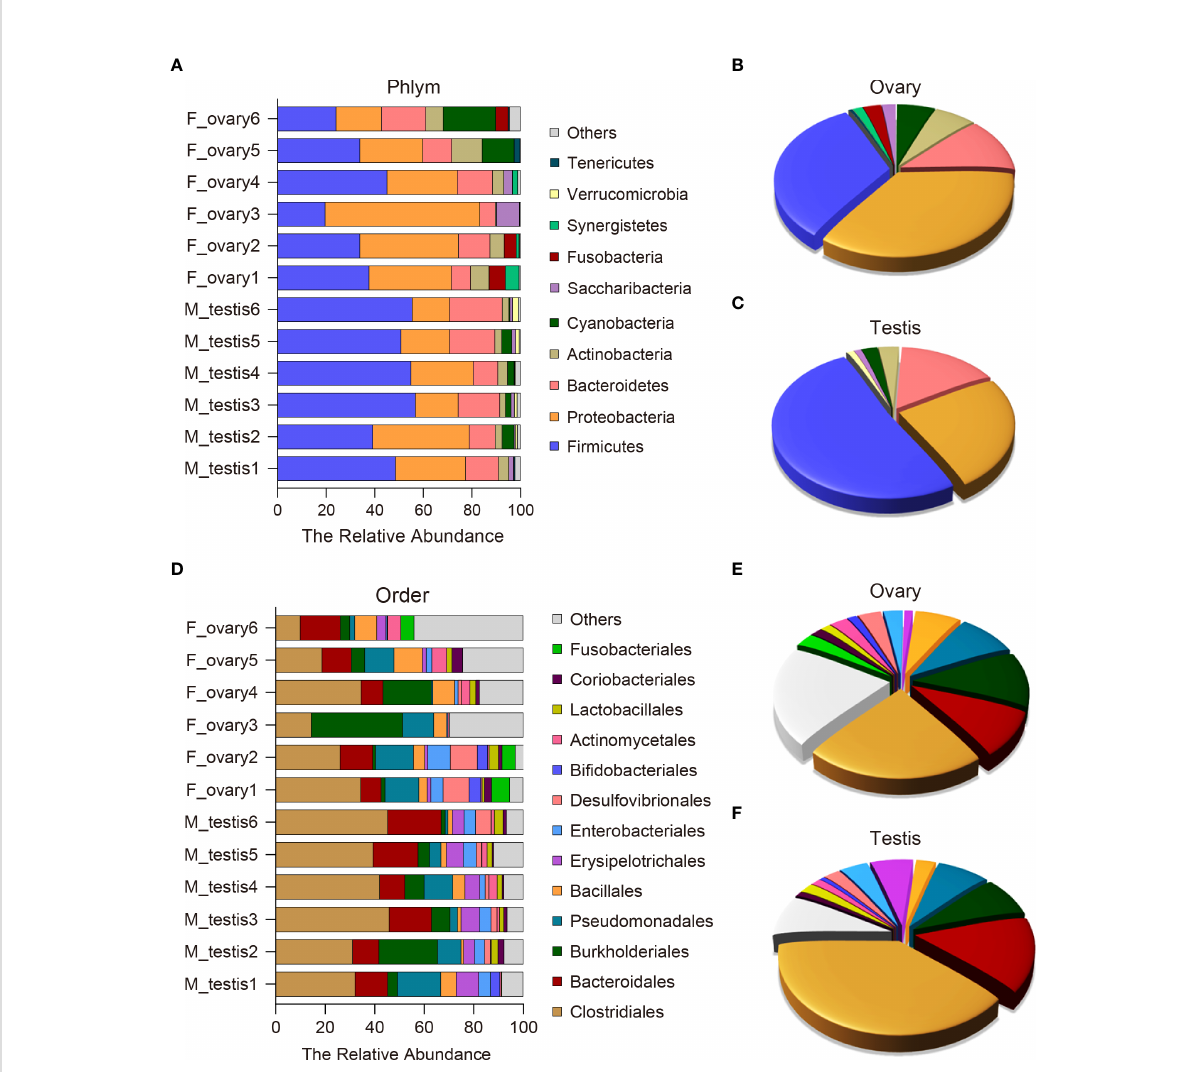
FIGURE 4 Composition and distribution of bacterial microbiomes in M. albus gonads. (A) Comparison of the composition and relative abundance of dominant bacterial taxa between ovary and testis at the phylum level. (B, C) Pie graphs represent the average relative abundance of each phylum in ovarian (B) or testicle (C) bacterial community. (D) Comparison of the composition and relative abundance of dominant bacterial taxa between ovary and testis at the order level. (E, F) Pie graphs represent the average relative abundance of each order in ovarian (E) or testicle (F) bacterial